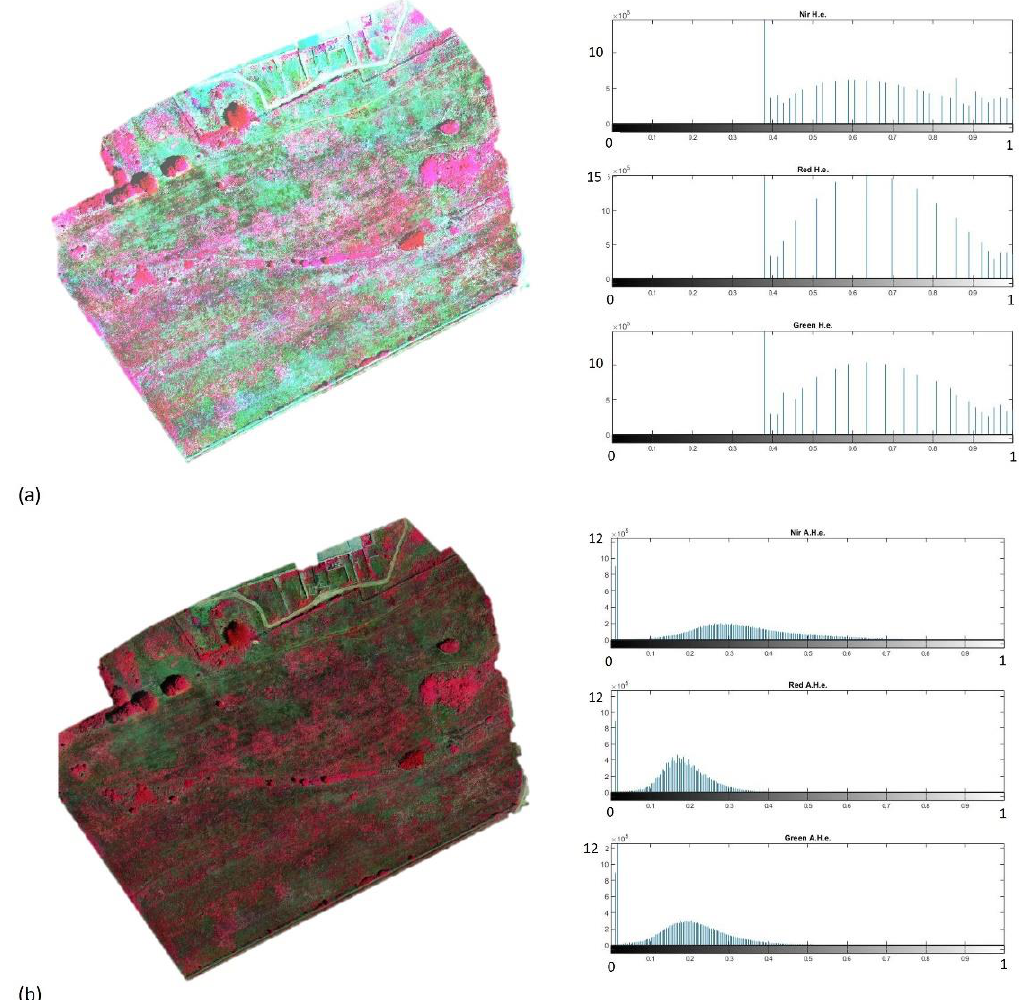
Figure 8. Example of ( a ) histogram equalisation and ( b ) adaptive histogram equalisation applied to July image.